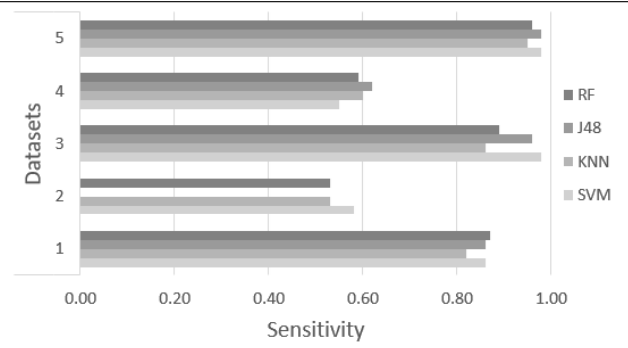
Figure 7. Difference in sensitivity among the different classification